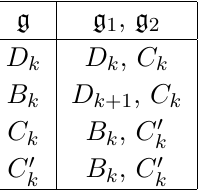
Table 3 . A theory with gauge algebra g , one adjoint hypermultiplet and N (cid:13)avors is mirror to a theory described by the circular quiver with 2 N nodes with alternating gauge algebras g 1 and g 2 given by the table.